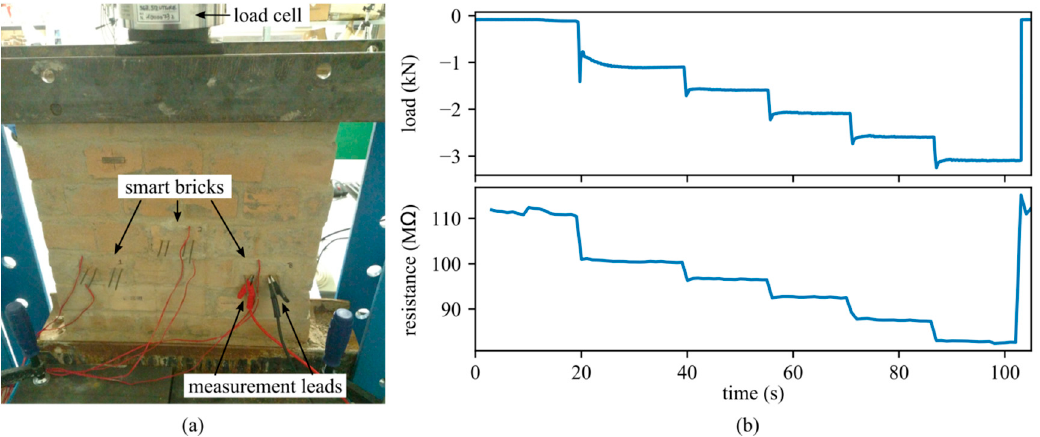
Figure 6. Example application of a smart brick embedded to measure strain in a masonry wall specimen: ( a ) Photo evidence of the smart brick in the wall; ( b ) Output of the smart brick under increasing compression